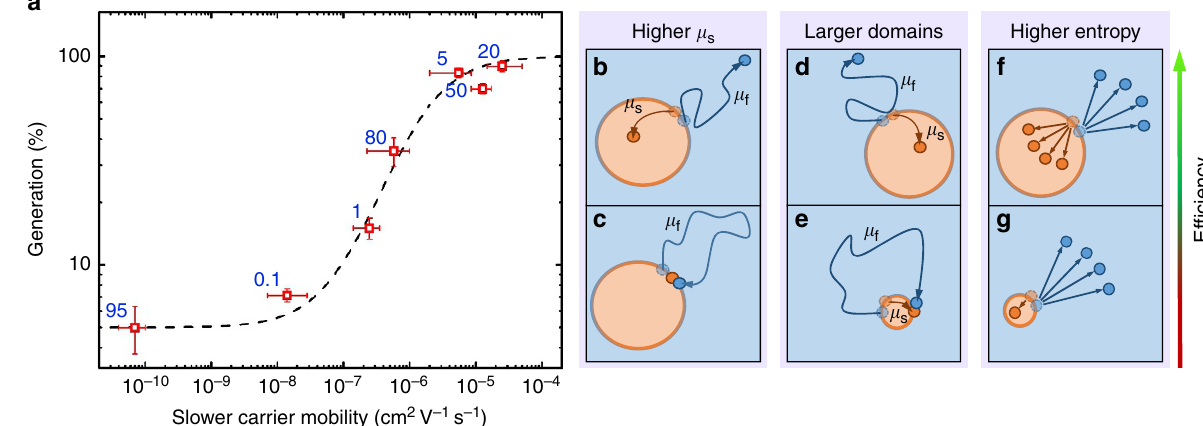
Figure 3 | Slower carriers limit charge transfer state dissociation and plausible explanations. ( a ) Generation yields versus slower carrier mobility— either holes or electrons depending on the donor content (the wt% is marked by the numbers). The dashed line is the prediction of Braun’s theory, assuming an offset in the generation yield at low mobilities and that the CTstate dissociation rate is determined by the slower carrier mobility and not the sum of both mobilities. The x -error is the range of the slower carrier mobility as obtained from two independent techniques (iPC and RPV), and the y -error bar is the first s.d. of the constant internal quantum efficiency regime (as described in Fig. 1). ( b , c ) Increasing the mobility of the slower carrier (orange dot in the dilute phase) enables it to leave the interface, which temporally protects the CTstate from recombination and allows the faster carrier (blue dot in the majority phase) to escape. ( d , e ) Larger domains of the dilute phase allow the slower carriers to travel further away from the interface, also protecting the CT state from recombination. ( f , g ) The entropic contribution to dissociation is maximized in systems where both carriers are mobile because the density of states of two separated charges is vastly larger than the density of states where only one charge is